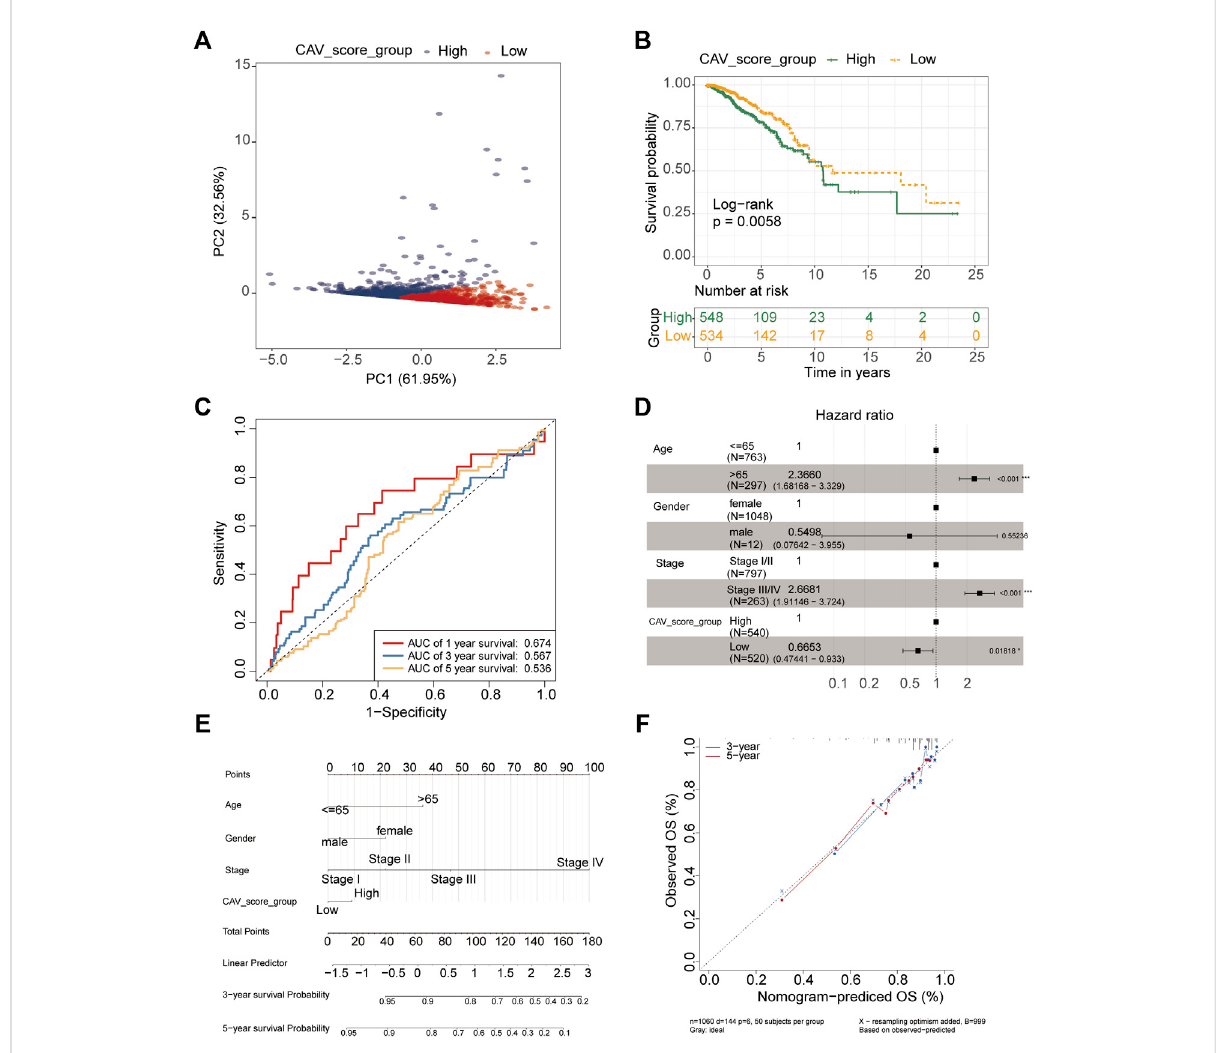
FIGURE 6 ConstructionandvalidationoftheprognosticmodelbasedonCAVgenesinBC. (A) PCAshowingthetwoclustersofsamples(PC1andPC2). (B) Kaplan – MeiersurvivalcurvesofOSbetweenthehigh-andlow-riskgroups. (C) SurvivalROCcurvesforpredictingOSofBCpatientsbytheriskscore. (D) Forest plot representation of the multivariate Cox regression analysis of the risk score and clinical features for BC. (E) Nomogram consists of the clinical features and risk scores of patients for predicting OS. (F) Calibration curves of the nomogram to predict OS at 3 and 5 years.